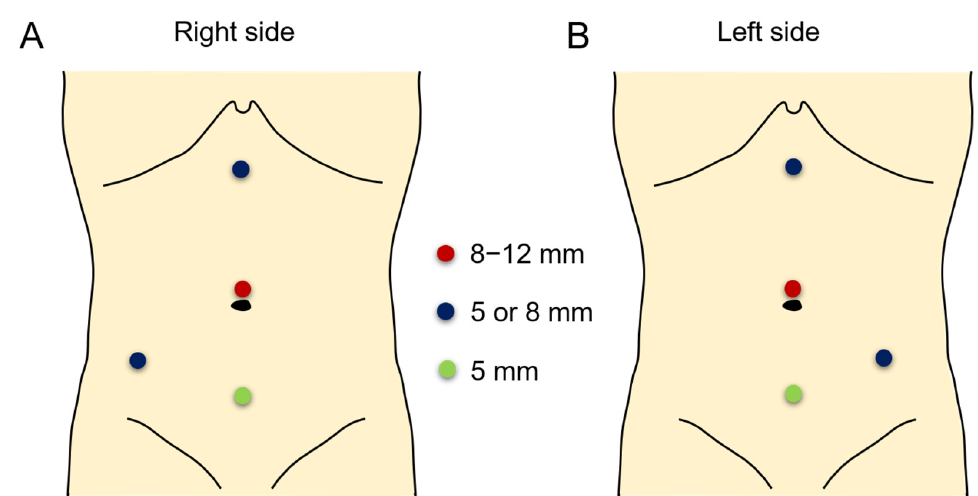
Figure 1. Port placement in right side ( A ) and left side ( B ) surgeries. The camera port was placed in the supraumbilical area with an 8, 8.5, or 12 mm port (red circle). The robotic arm ports were placed at the subxiphoid and lower abdominal areas (blue circles). An assistant port was placed at the suprapubic area (green circle).